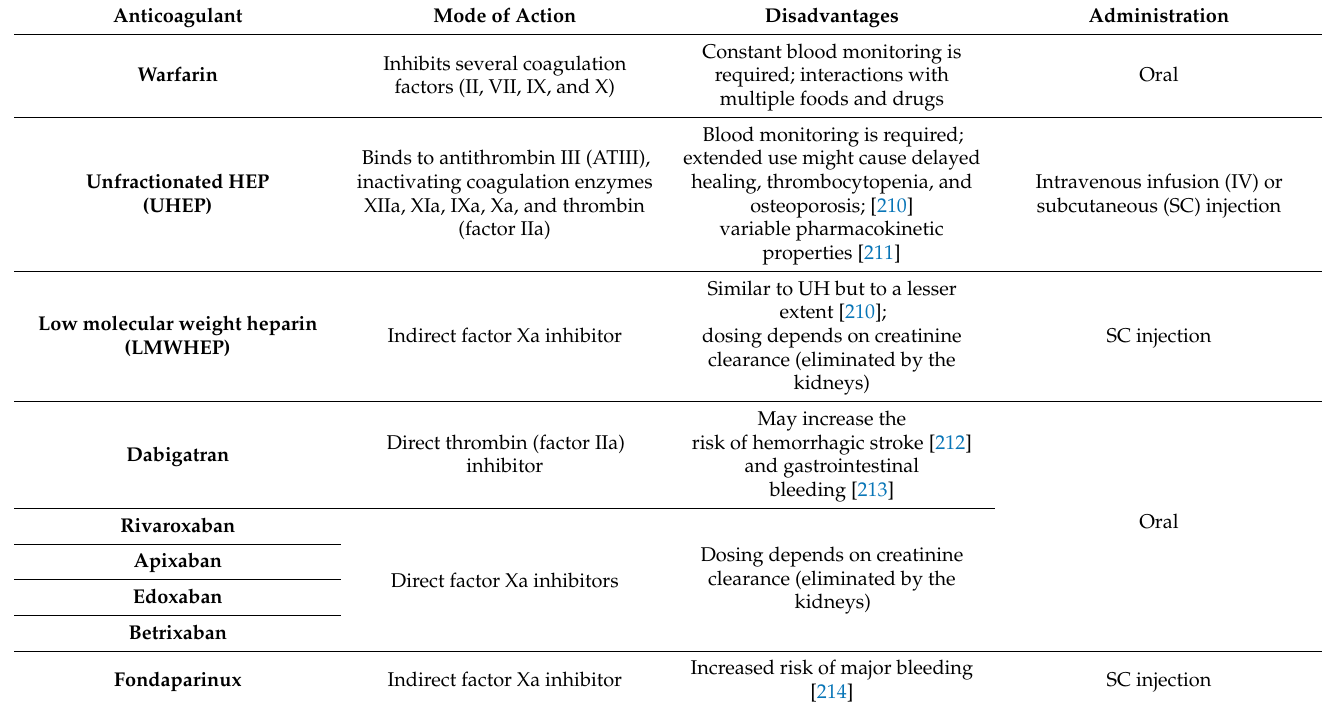
Table 7. A list of anticoagulants used in clinical